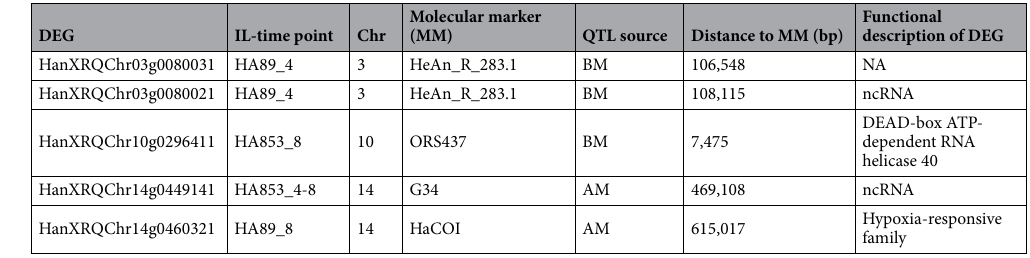
Functional description of